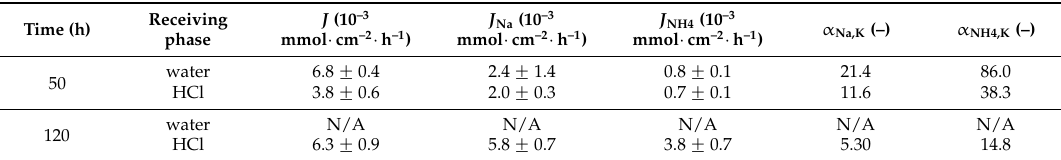
Table 6. Selectivity and flux of K + , Na + , NH 4+ after 50 and 120 h. Receiving solution was ultrapure water or 100 mM HCl.